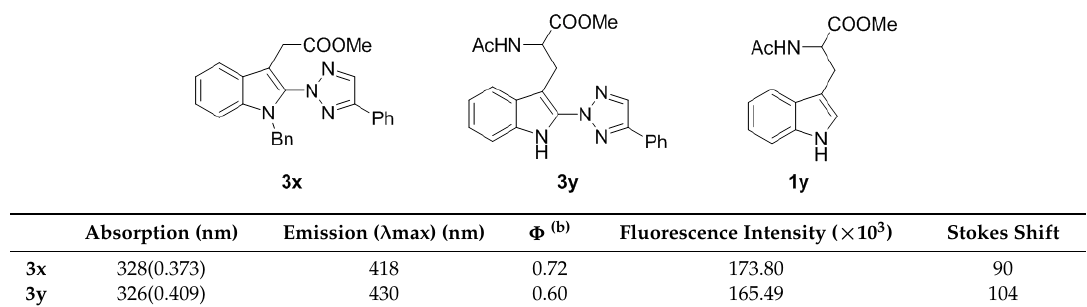
Table 4. Fluorescence emission behavior of compounds 3x and 3y (a) .